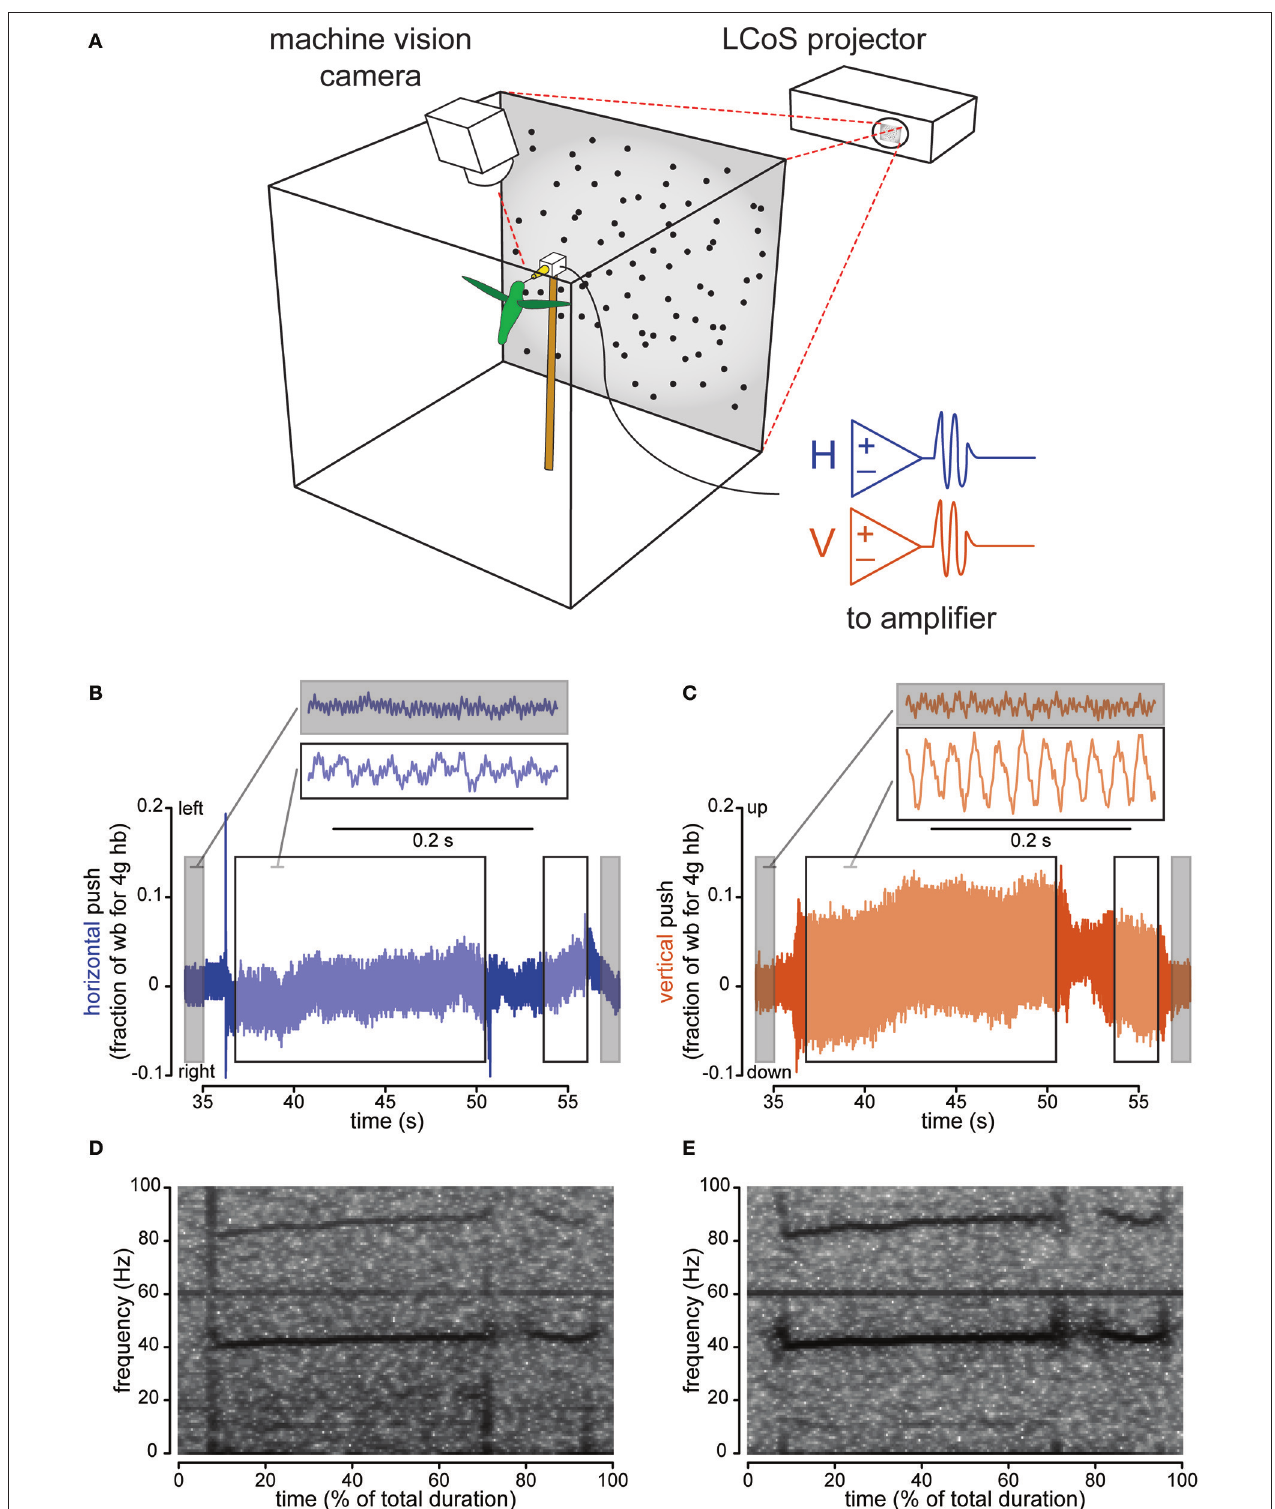
FIGURE 1 | Instrumented feeder measures how hovering hummingbirds interact with the feeder once docked. The flight chamber (A) is a 0.5m cube with a back-projection screen on one wall and a feeder centered in front of it. Horizontal and vertical strain, as well as video, are recorded and computer generated visual stimulus is presented behind the feeder. Strain recordings show pushing against the feeder in body weight units (assuming an average 4g Anna’s hummingbird) for